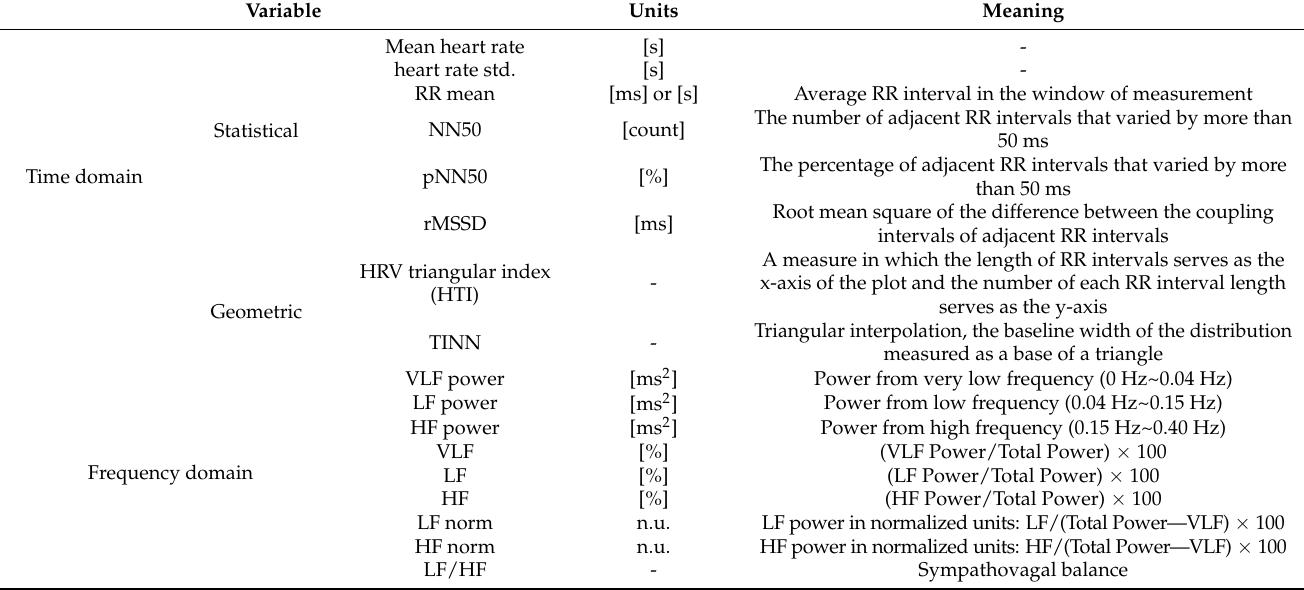
Table 6. Indices concerning time- and frequency-domain methods of